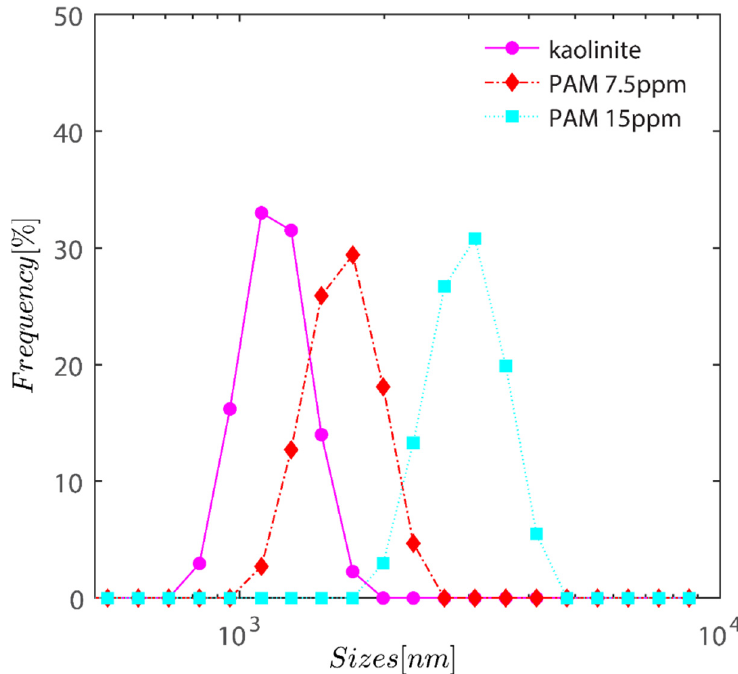
Figure 2. Semi-logarithmic variation of volume percentage as a function of hydrodynamic radius of kaolinite. The graph displays a gradual shift in volume-averaged particle size as PAM dosage increases from 0 to 15 ppm.